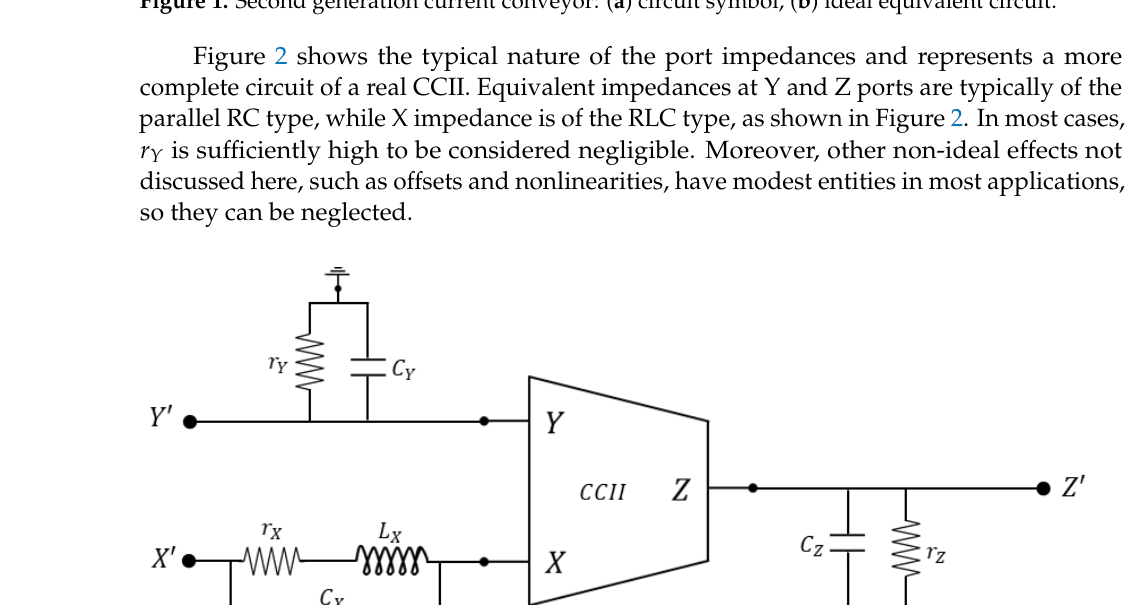
Figure 1. Second generation current conveyor: ( a ) circuit symbol, ( b ) ideal equivalent circuit.